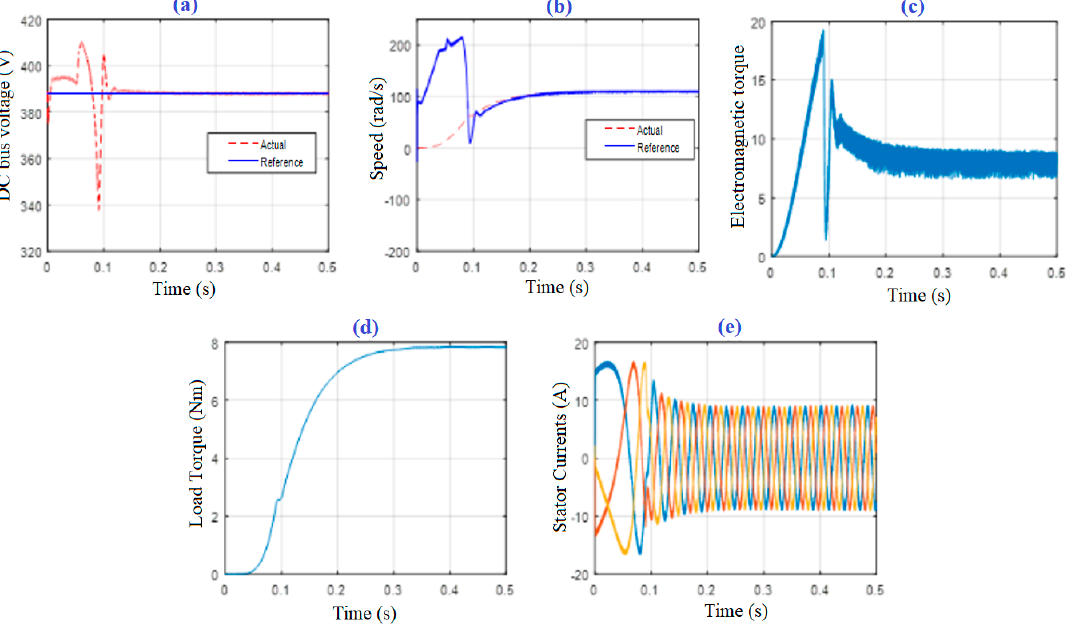
Figure 12. The detailed performance of SPVWP system under second scenario using P&O based tracker.